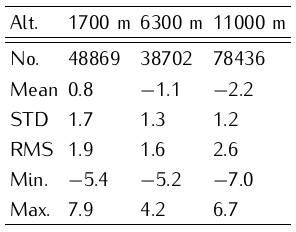
Table 2. Statistics of the residual gravity anomalies (airborne - EGM08). Units in